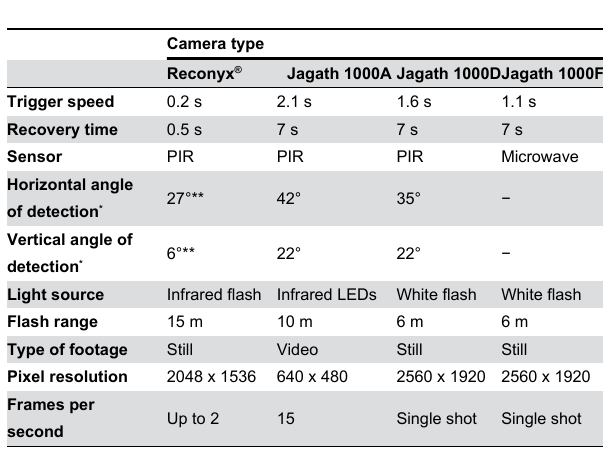
*. Calculated using trigonometry based on detection zones as shown in Figure 2. For a camera set at ground height. Due to alignment of sensors the detection zone is wider for a camera mounted higher